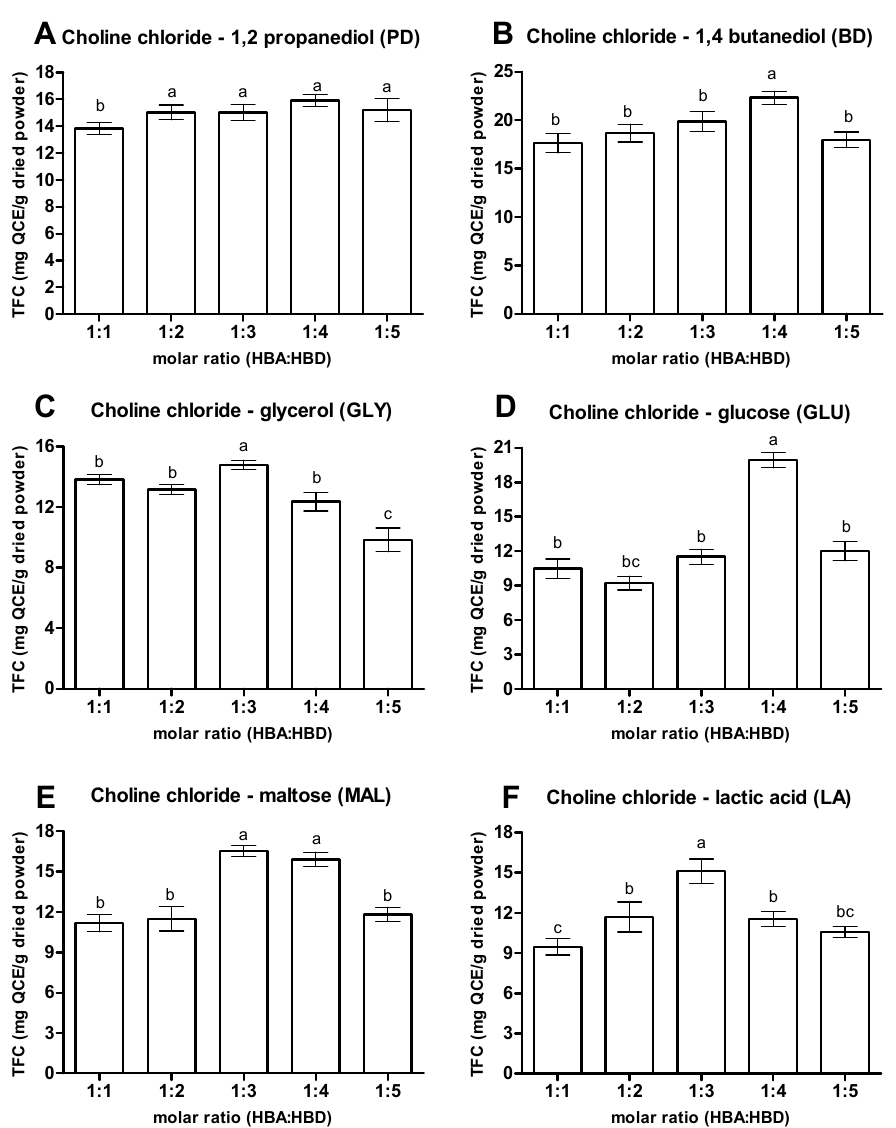
Figure 4. Effect of different molar ratios of NaDES. ( A ) Choline chloride—1,2 propanediol, ( B ) Choline chloride—1,4 butanediol, ( C ) Choline chloride—glycerol, ( D ) Choline chloride— glu- cose, ( E ) Choline chloride—maltose and ( F ) Choline chloride—lactic acid. Values are presented as mean ± standard deviation of three measurements. Values marked with different letters indicate comparison among molar ratios in NaDES which are a statistically significant differences at p < 0.05. HBA, hydrogen bond acceptor; HBD, hydrogen bond